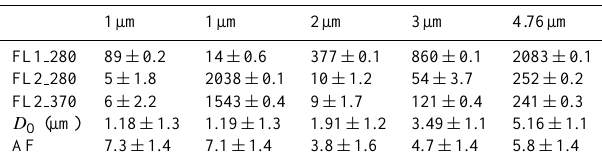
Table2. AveragemodalcentresofPSLdatainputtoclusteranalysisalgorithm. N , and the concomittant rise in RMS (Figure 4). Of these 13 clusters, the six major clusters were retainedforsubsequentanalysis(Table3). Itshouldbenotedthat,inthisinstance,thedifferentPSLs arelikelytobepresentinconcentrationsofasimilarorderofmagnitude,meaningthateachPSLtype islikelytoberesolvedasamajorcluster. Figure5showstheinputsingleparticlesizemeasurements asafunctionoftime,colouredbycluster,andbelowthat,acomparisonofclusterconcentrationtime series generated using the attribution methods described above. Both fuzzy attribution sets used a significant distance limit ( d l ) of five, which was set at the minimum value at which most particles are successfully attributed.